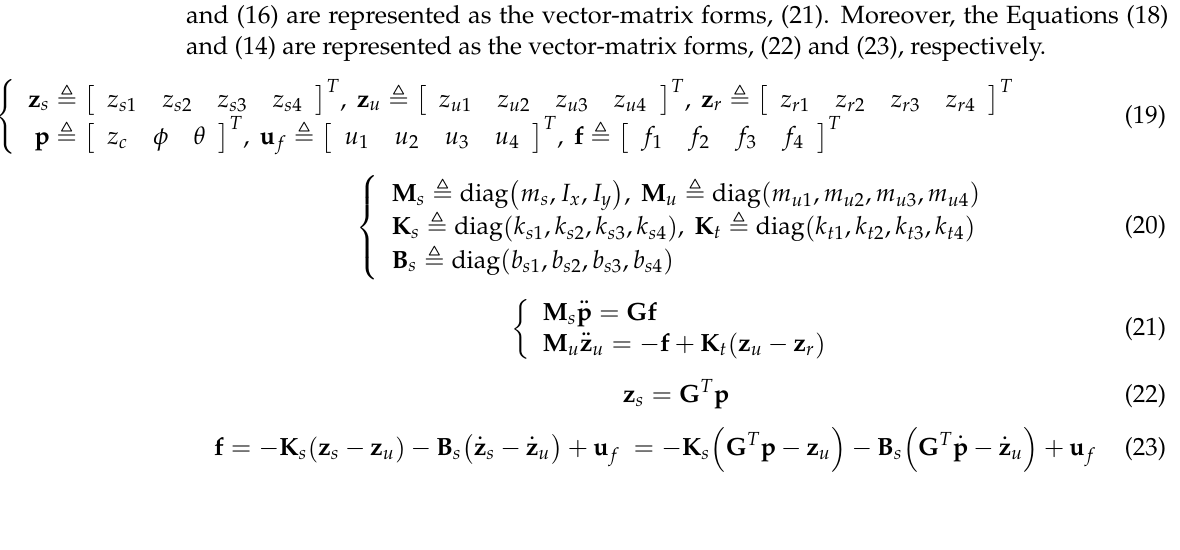
Figure 4. Roll and pitch motions of the sprung mass. ( a ) Roll motion (front view); ( b ) Pitch motion (side view).